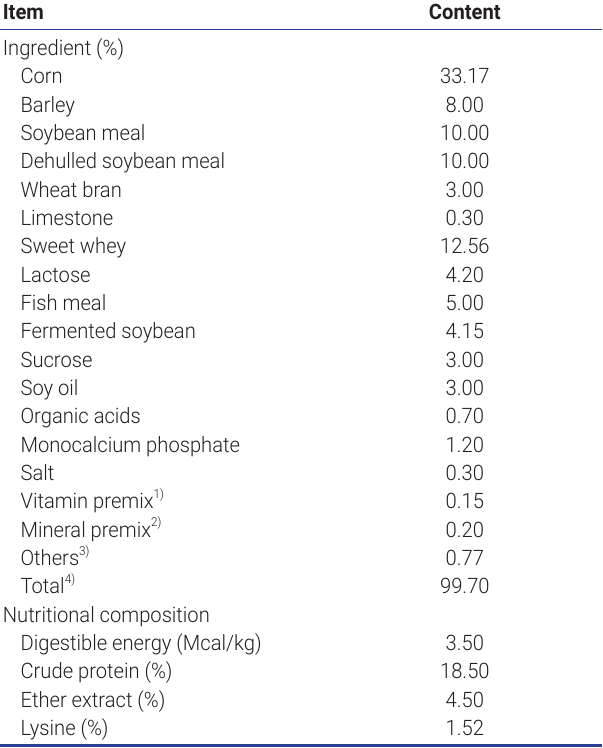
Table 1. Composition of the basal diet (as-fed basis)